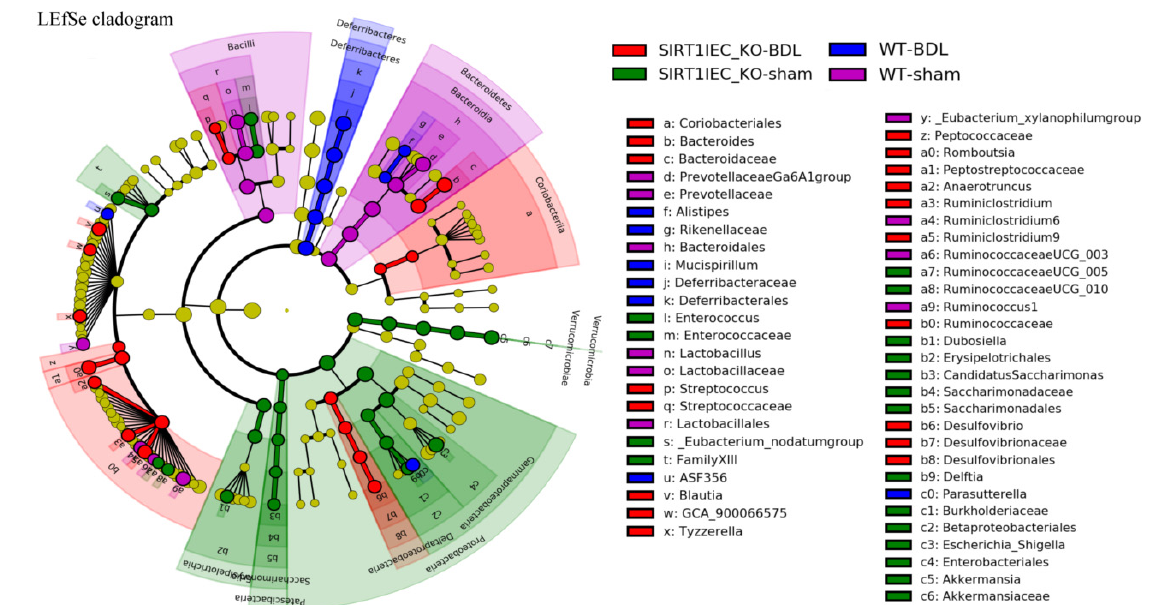
Figure 6. Intestinal SIRT1 deficiency decreases the diversity of bacterial microbiota. Intestinal LEfSe cladogram representing bacteria taxon with statistical significance and biological relevance fecal bacteria in WT BDL (blue), SIRT1 IEC KO -BDL group (red), WT-sham (purple), SIRT1 IEC KO -sham (green). Rings from the inside out represented taxonomic levels from phylum, family to genus levels. Sizes of circles indicate the relative abundance of the taxa.